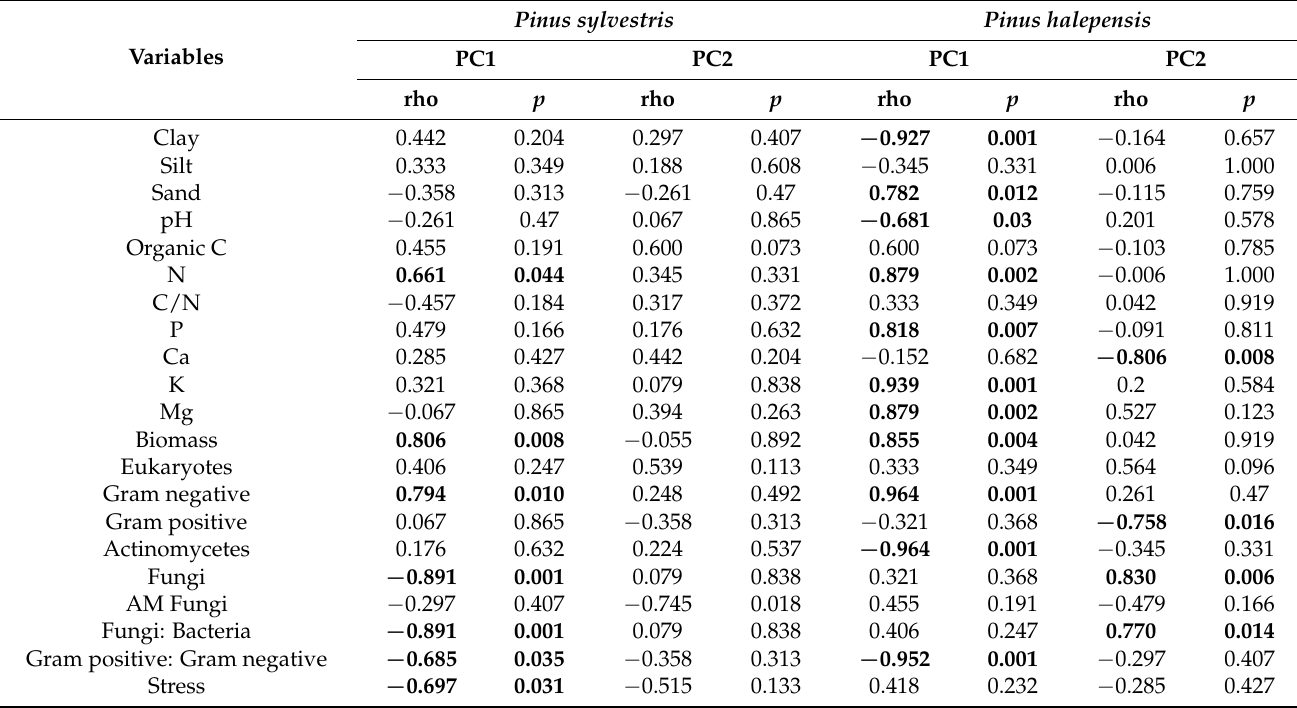
Table 3. Correlation coefficients (Spearman rho) calculated between the first (PC1) and second (PC2) principal components of a Principal Component Analysis while considering data on soil texture, nutrients concentrations and microbial community composition. For each variable, the correlation coefficient (Spearman rho) and associated probability ( p ) are shown. Significant values ( p < 0.05) are shown in